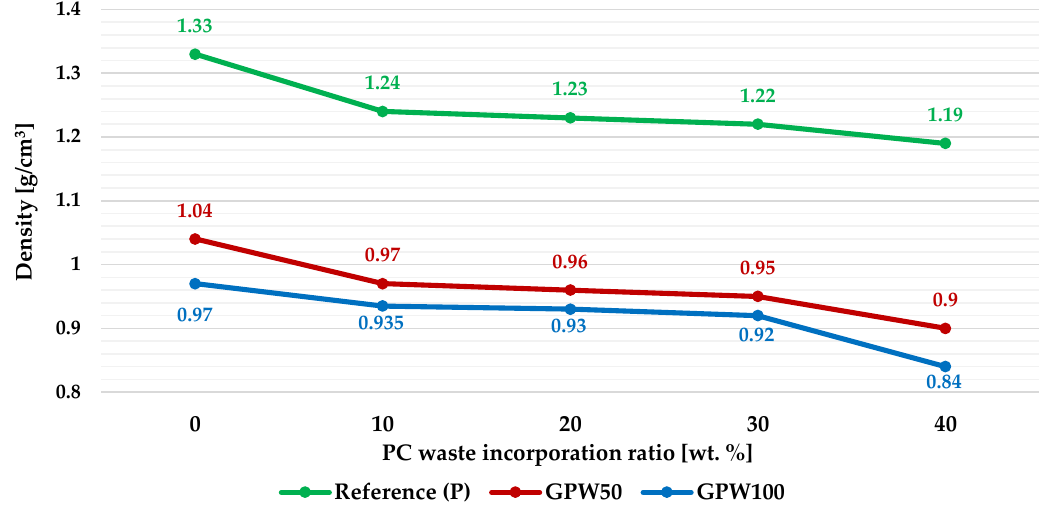
Figure 4. Dry bulk density of the developed gypsum plasters.